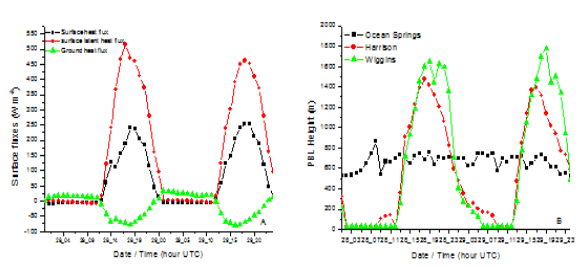
Figure 15 : WRF simulated surface fluxes at Harrison (a) and simulated boundary layer height at Ocean Springs, Harrison and